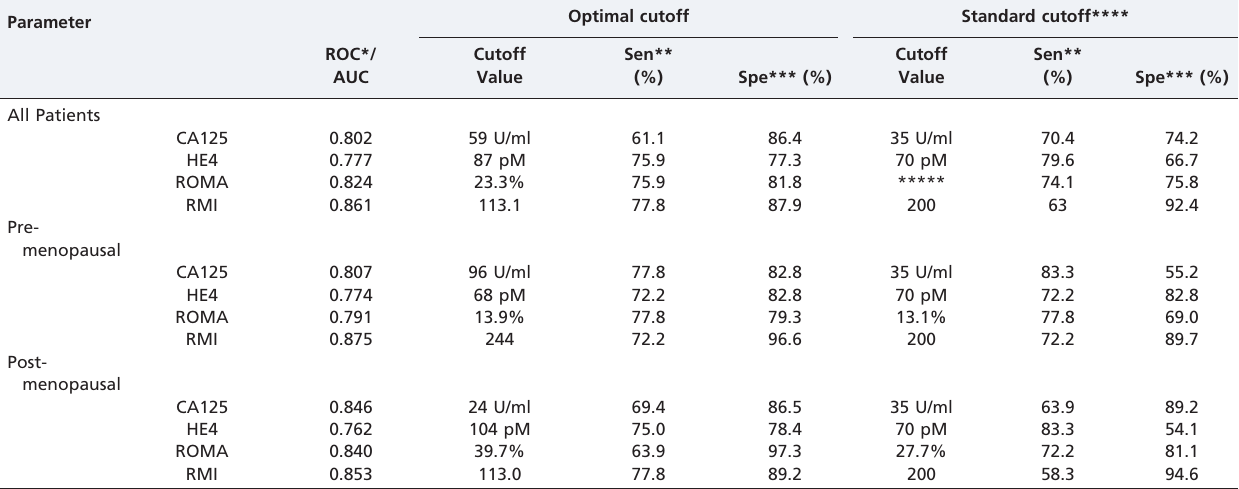
Table 2 - The sensitivity and specificity values associated with CA125, HE4, ROMA, and RMI for pre- and post– menopausal patient groups at the optimal identified cutoff value and the standard cutoff value for each method.